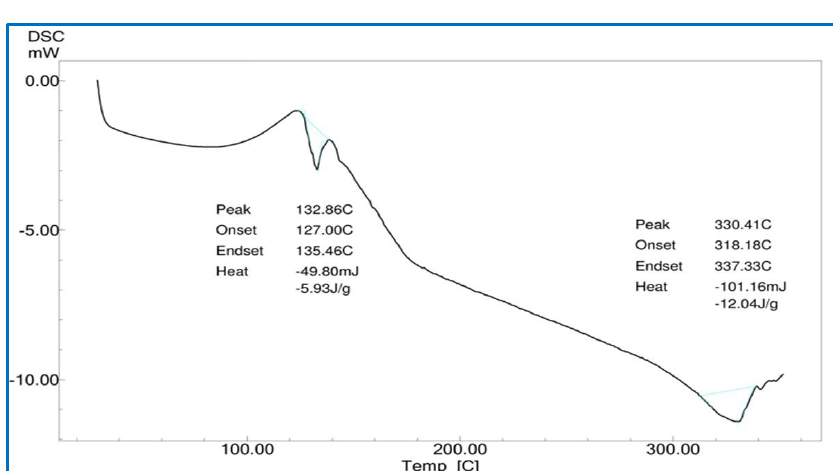
Figure 6. DSC of gelatin sponge.